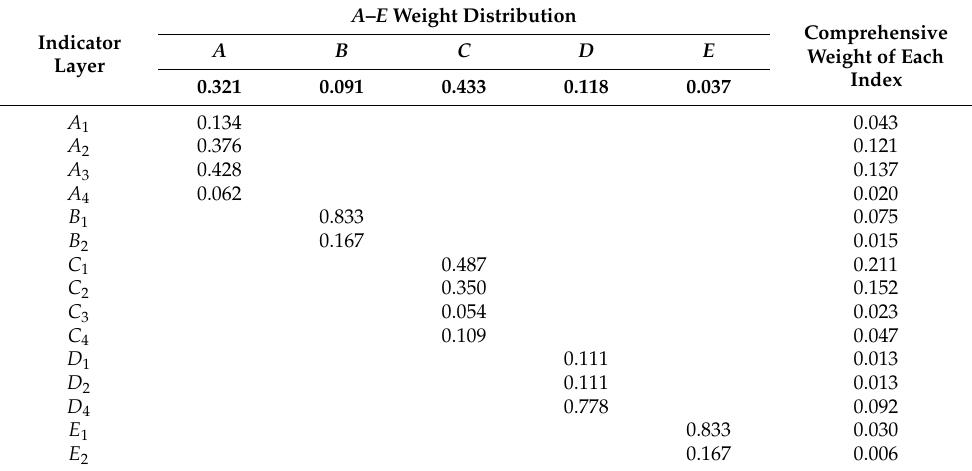
Table 12. Combined weights of